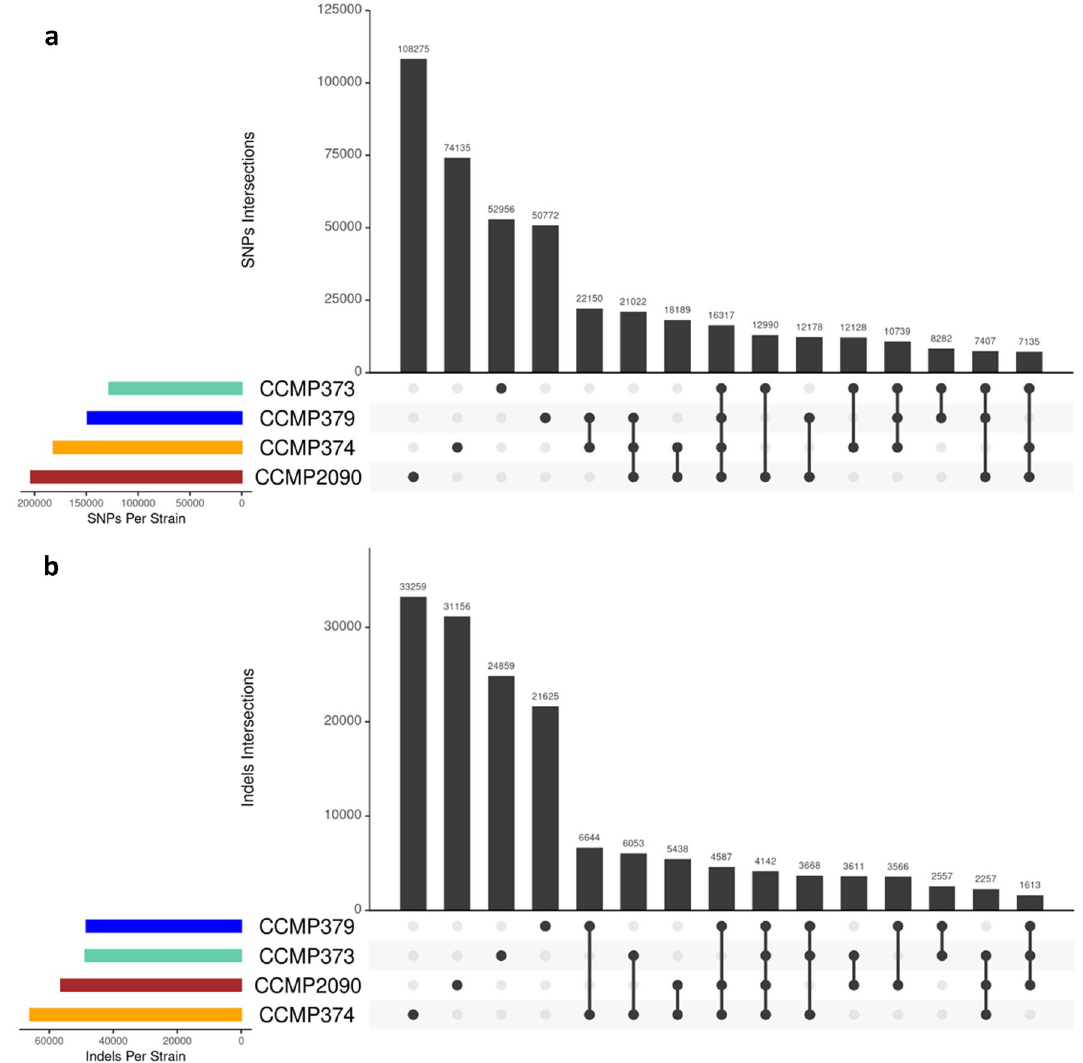
Figure 2. Upset plots showing the level of genetic variation in four E. huxleyi strains. The plots visualize intersections between the strains and the number of elements in each intersection for ( a ) SNPs and ( b )